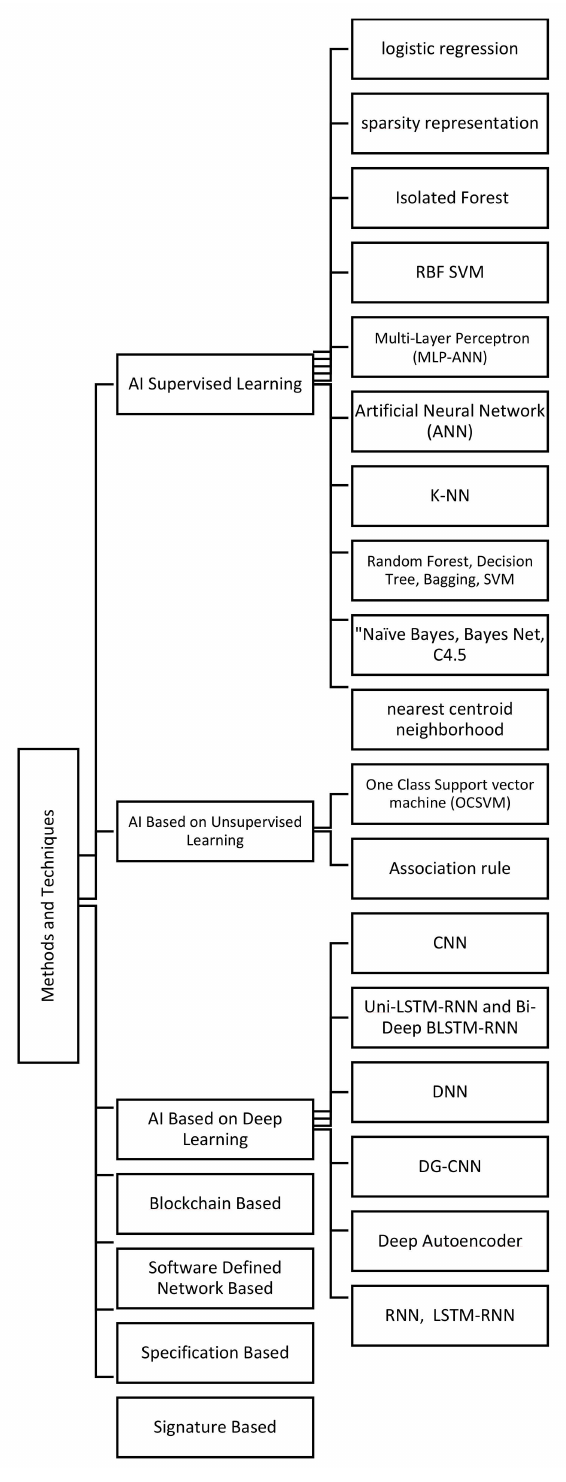
Figure 12. Methods and techniques extracted from the selected